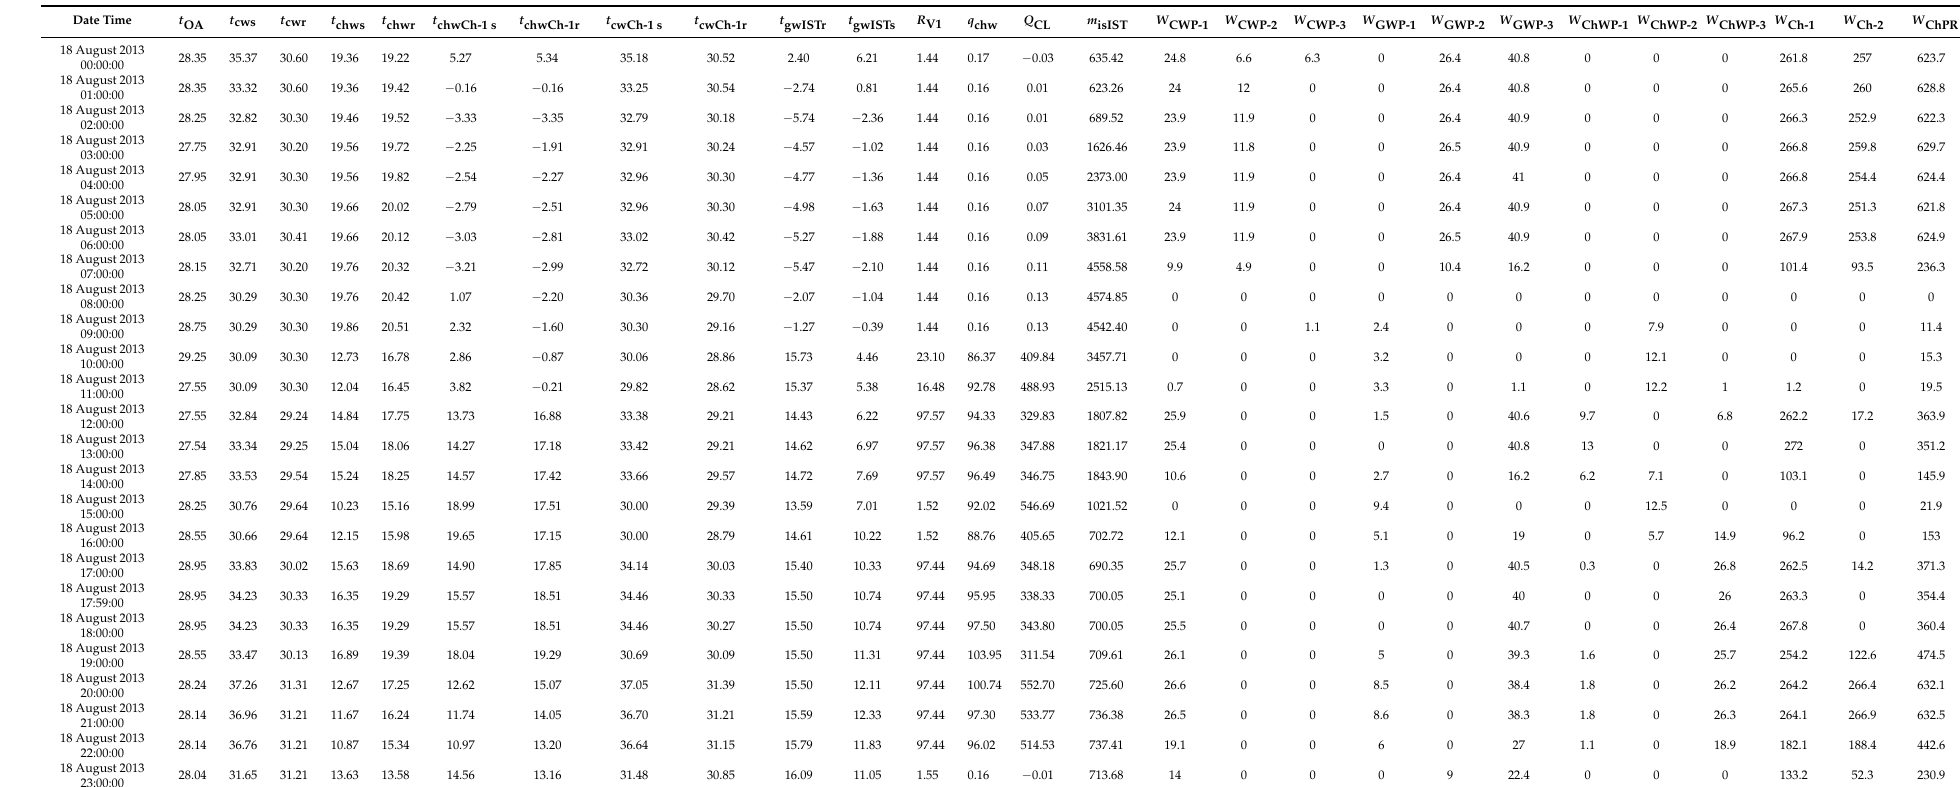
Table A2. Selected raw data collected on 18 August